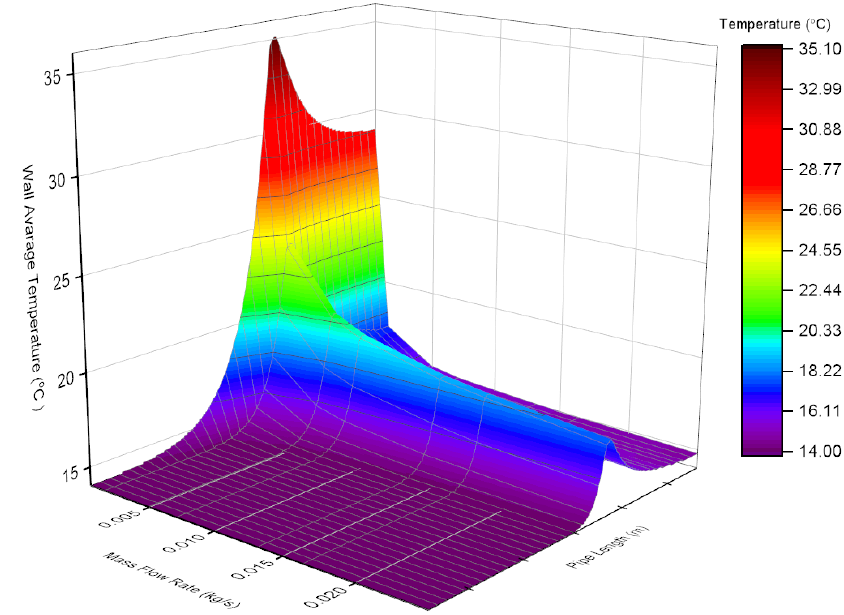
Figure 15. Average wall temperature along the pipe at different mass flow rates.